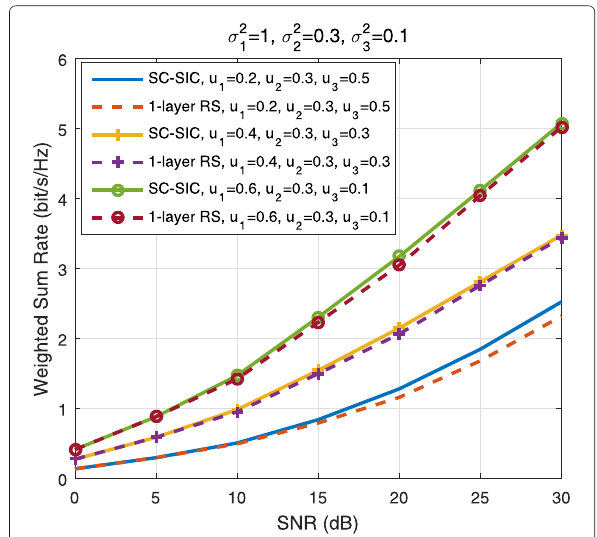
Fig. 17 Weighted sum rate versus SNR comparison of different strategies for overloaded three-user deployment with perfect CSIT, = 1, σ 2 = 0.3, σ 2 = 0.1, N = 1, r = [0,0,0.01,0.03,0.1,0.2,0.3] σ 2 t th 1 2 3